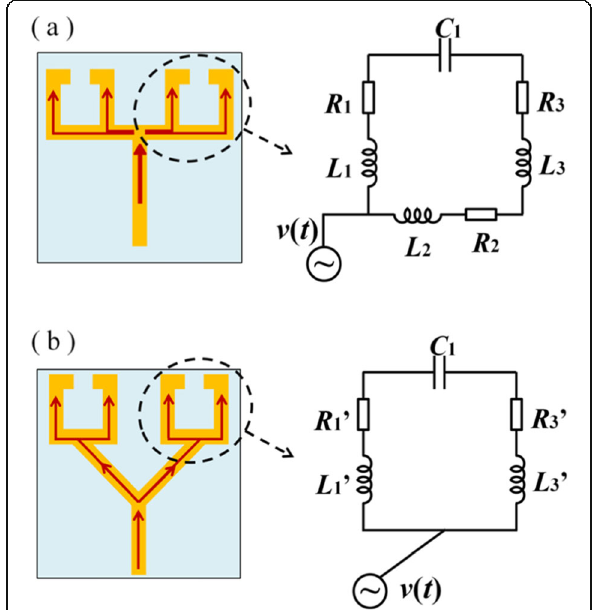
Fig. 6 Electric circuit modeling the response of the conductively coupled terahertz metamaterial in which the junctions are located a on one side of the vertical center line of the SRRs; b on the vertical center line of the SRRs